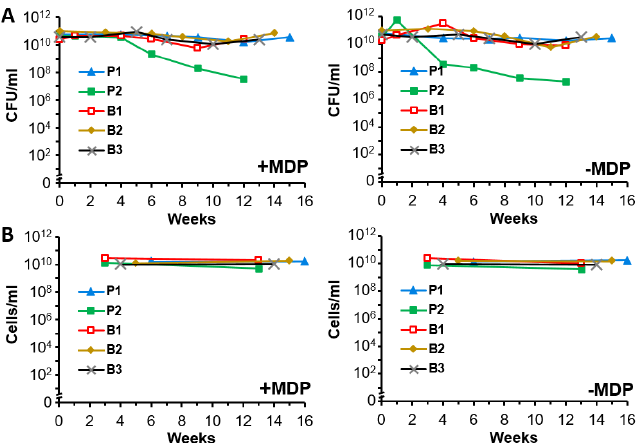
Figure 4. Stability of unirradiated and irradiated bacterial cultures. ( A ) Stability of unirradiated A. baumannii at 4 °C. P1, P2, B1, B2, and B3 cultures were prepared with or without the MDP complex and stored at 4 °C for up to 16 weeks at concentrations between 10 10 and 10 11 CFU/mL. A portion of each sample was removed for colony counting by plating serial dilutions on agar plates at the indicated time points. ( B ) Stability of irradiated A. baumannii at 4 °C. P1, P2, B1, B2, and B3 cultures were prepared with or without the MDP complex, exposed to 10 kGy gamma irradiation, and stored at 4 ° C for up to 16 weeks at concentrations between 10 10 and 10 11 CFU/mL. A portion of each sample was removed and serially diluted for microscopic examination. The concentration of intact cells/mL are reported at the indicated time